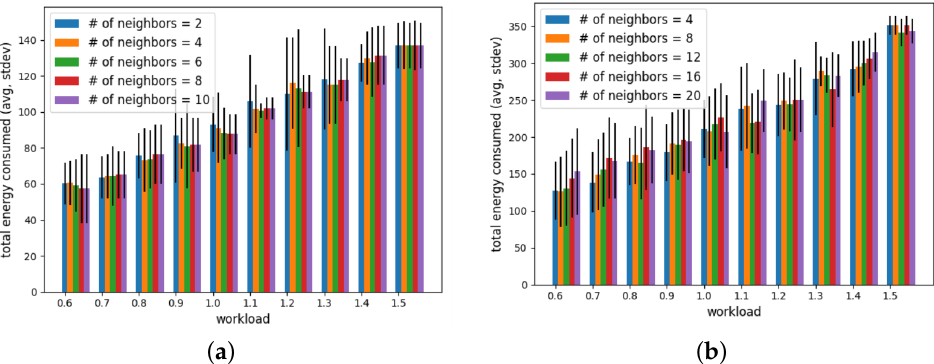
Figure 9. Total energy consumption when the neighborhood range varies and q th = 0.5. ( a ) The number of MECSs is 10; ( b ) The number of MECSs is 20.